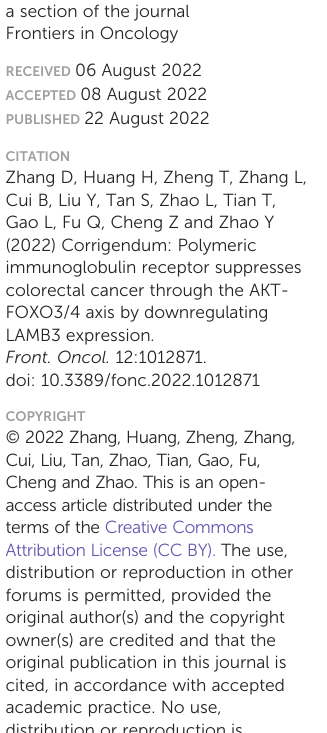
slides of migration of “ Vector ” group and “ PIGR+ LAMB3 ” group were misused in Figure 4G due to carelessness. The corrected Figure 4 and its caption appear